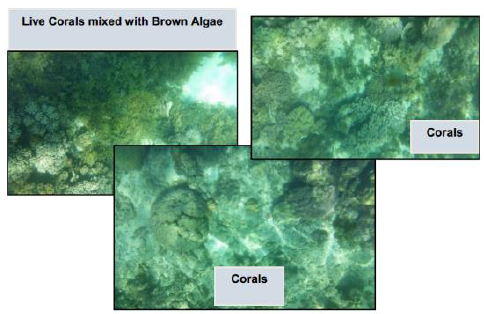
Figure 11. Validation areas with corals in the study